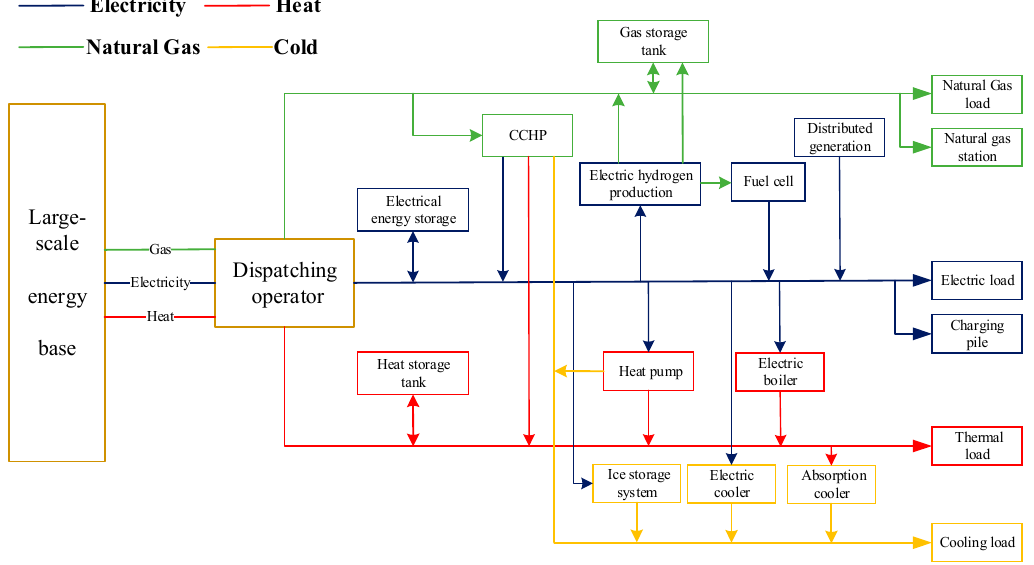
Figure 1. Structural frame of integrated energy system (IES).